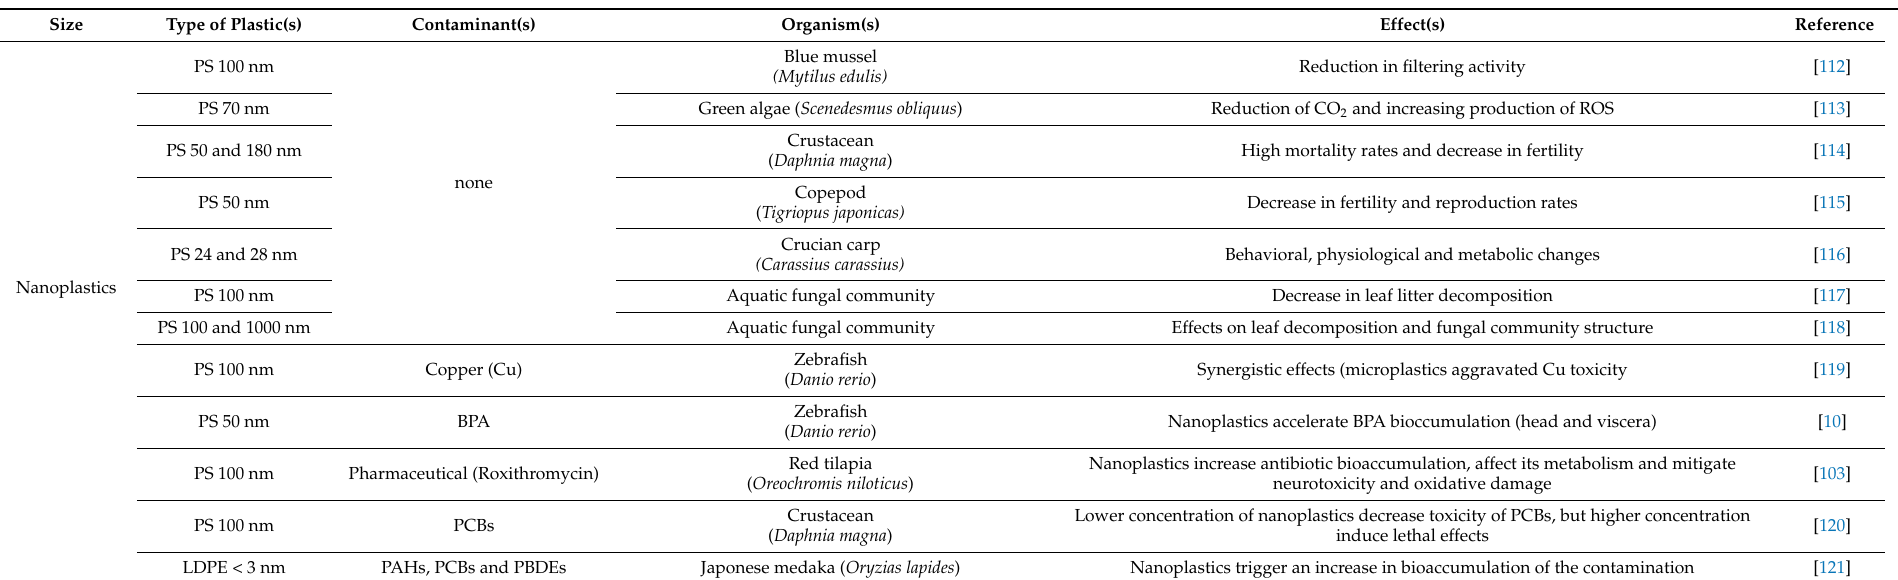
Table 1. Studies assessing the effects of different types of contaminants combined with nano- and micro-plastics. PS—polystyrene,